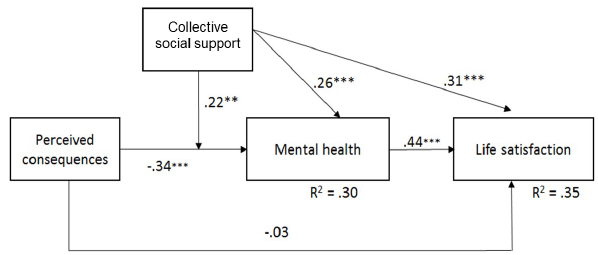
Figure 3. Path model with life satisfaction as dependent